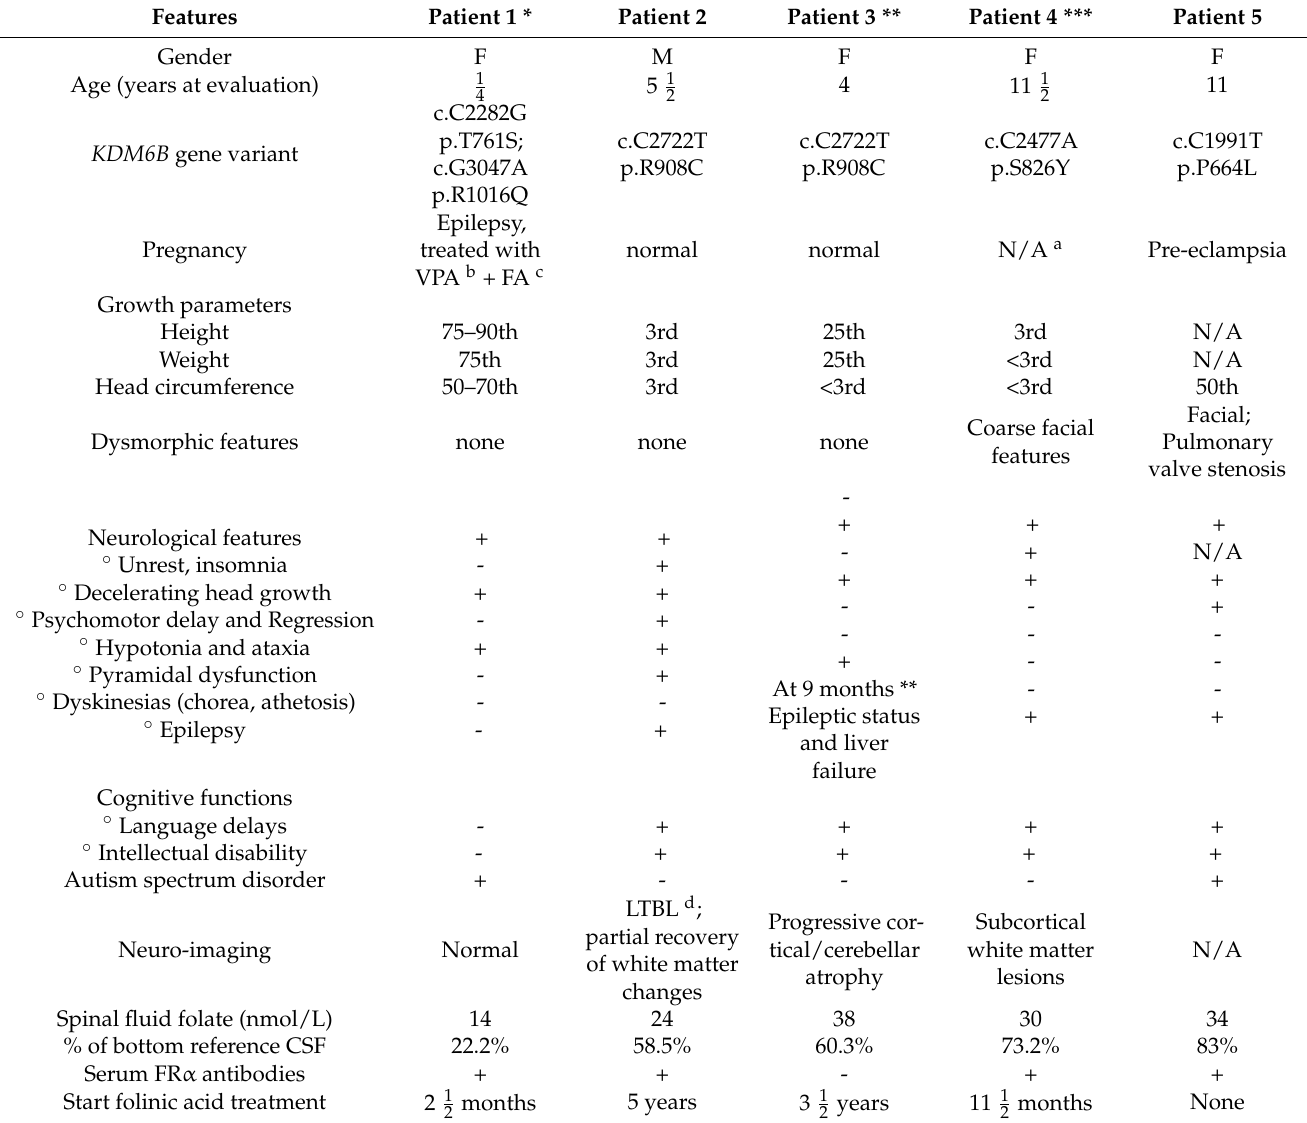
Table 1. Clinical features of patients with KDM6B